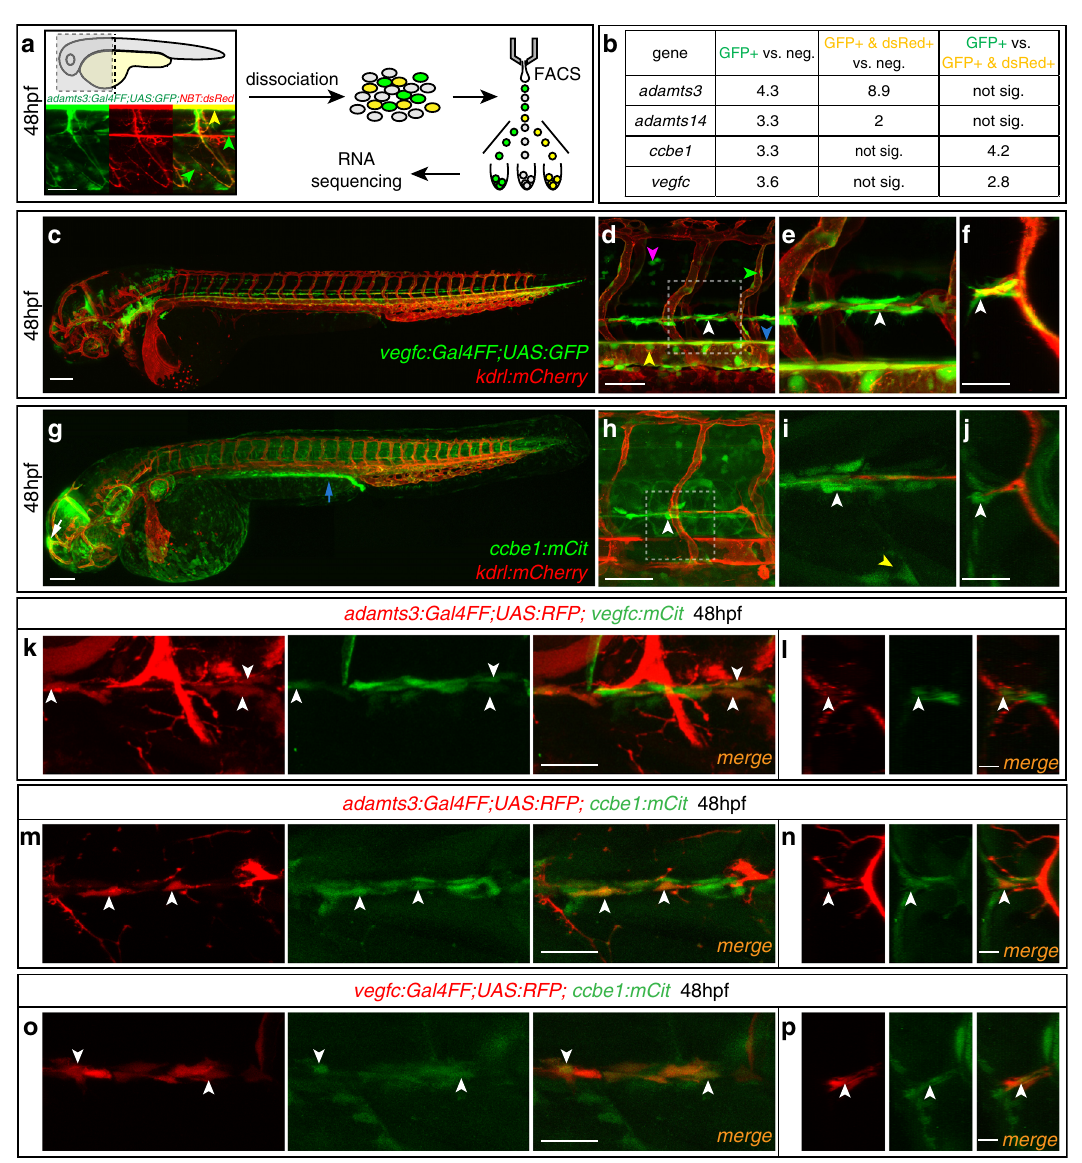
Fig. 7 Non-neuronal adamts3 -expressing cells co-express vegfc and ccbe1 . a Strategy for transcript analysis of adamts3 -expressing cell populations by RNA sequencing. adamts3:Gal4FF;UAS:GFP ; NBT:dsRed -positive trunks were dissociated at 48 hpf and cells were FAC-sorted into (1) adamts3 -expressing neurons (GFP + /dsRed + , yellow arrowhead), (2) adamts3 + non-neuronal cells (GFP + , green arrowheads) and (3) a negative control. Pooled cell populations were analyzed by RNA sequencing. b Summary of RNA sequencing analysis. Values re fl ect fold-changes in transcript abundance for indicated genes upon comparison of cell populations stated in the column headings. To identify signi fi cant gene expression differences, p values were determined by Wald test and an FDR < 0.05 and FDR-adjusted p value < 0.1 cutoff was used (source data are provided as a Source Data fi le). c Lateral view of a vegfc: Gal4FF; UAS:GFP; kdrl:mCherry transgenic embryo at 48 hpf. d Higher magni fi cation showing vegfc expression in HM cells (white arrowhead), in the hypochord (blue arrowhead), the DA (yellow arrowhead), in arteries (green arrowhead) and in neurons (magenta arrowhead). e Zoom-in of the boxed region in ( d ) highlighting vegfc -expressing cells at the HM (arrowhead). f Virtual cross section focusing on the HM, showing juxtaposition between a PL and vegfc -expressing cells (arrowhead). g Lateral view of a ccbe1:mCitrine; kdrl:mCherry transgenic embryo at 48 hpf showing ccbe1 expression in the pronephros (blue arrow) and epiphysis (white arrow). h Higher magni fi cation demonstrating ccbe1 expression at the HM (arrowhead). i Partial projection of the marked region in ( h ) showing ccbe1 -expressing cells at the HM (white arrowhead) and the segment boundary (yellow arrowhead). j Virtual cross section indicating ccbe1 + cells at the HM (arrowhead). k , m , o Lateral views (partial z-projections) and l , n , p virtual cross sections of the HM region at 48 hpf. Arrowheads indicate cells with co-expression of the indicated transgenes. k , l adamts3 and vegfc are co-expressed by individual cells at the HM. m , n Mesenchymal cells at the HM co-express adamts3 and ccbe1 . o , p Overlapping expression of vegfc and ccbe1 in HM cells. Scale bars in a , d , h : 50 µ m; c , g : 100 µ m; f , j , k , m , o 25 µ m; l , n , p : 10 µ m. DA dorsal aorta, HM horizontal myoseptum, hpf hours post fertilization, neg. negative cell population, sig. signi fi